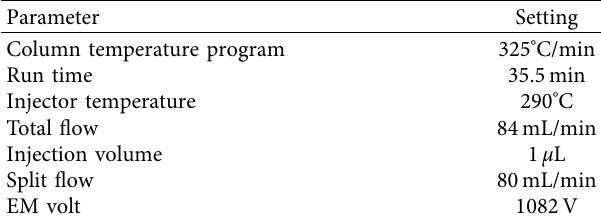
Table 1: GC-MS parameters for the analysis of biodiesel. Parameter Setting